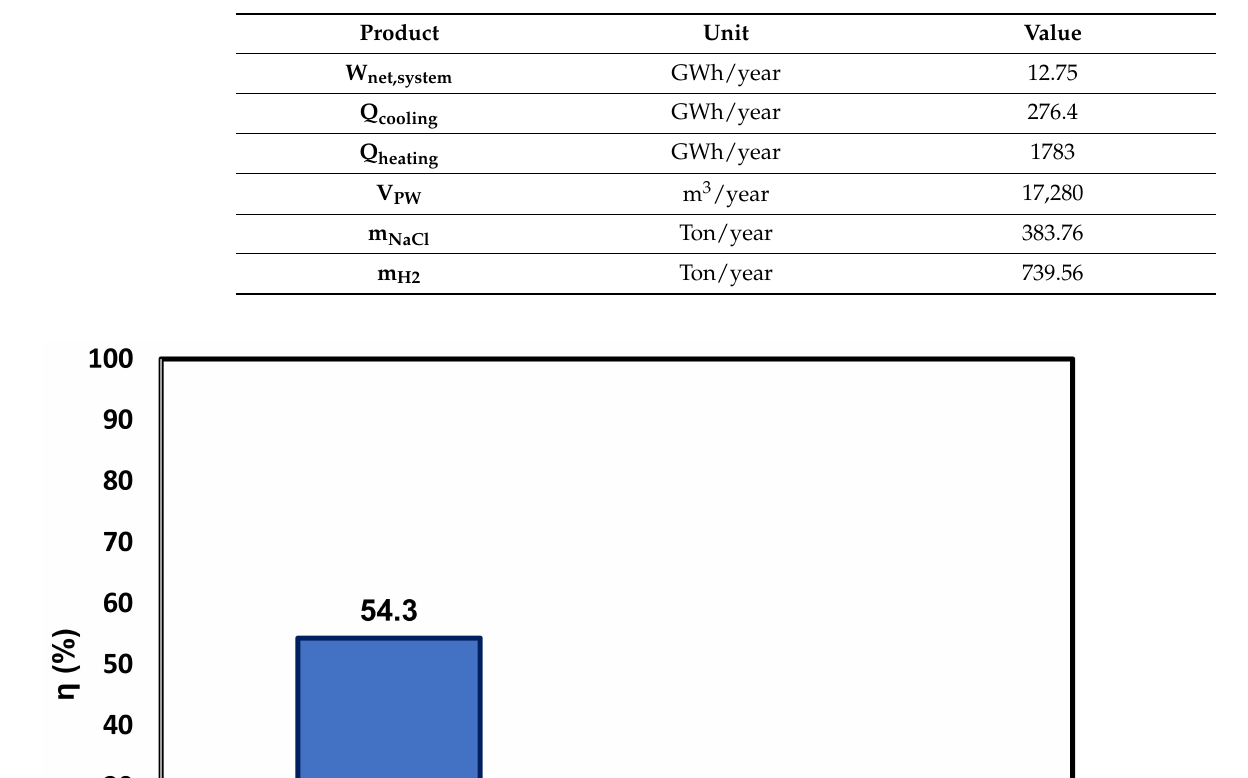
Table 13. The values of system products.